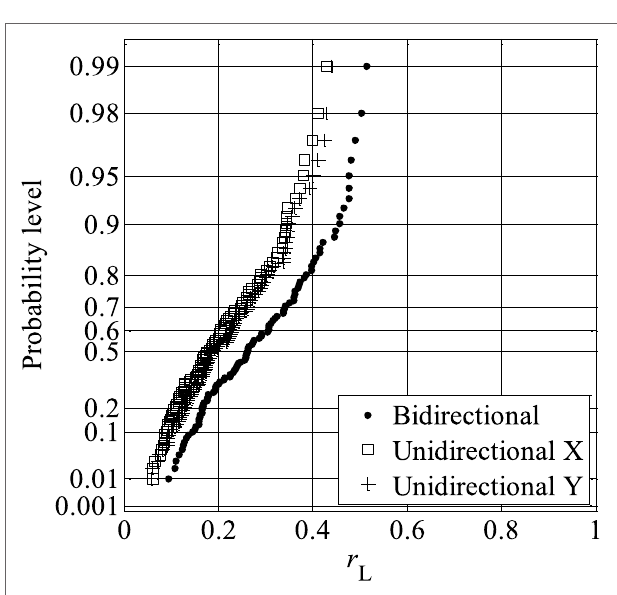
FIGURE 6 | Aggregated seismic loss for the 100 buildings under the scenario earthquake plotted on Gumbel probability paper.